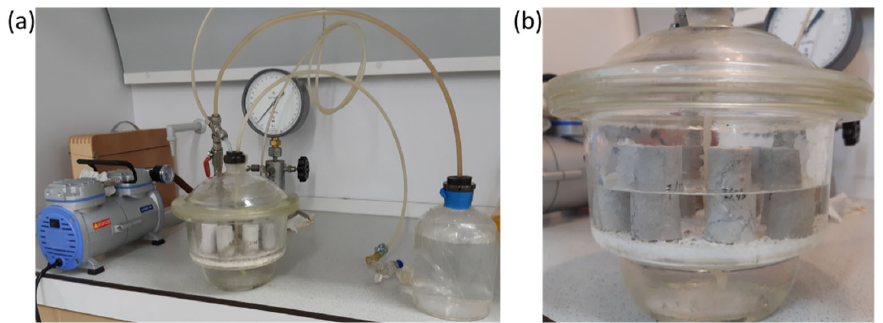
Figure 4. Photographs depicting the process of saturation of geomaterial samples: ( a ) sample saturation unit AST ‐ 600; ( b ) limestone samples during vacuum saturation.